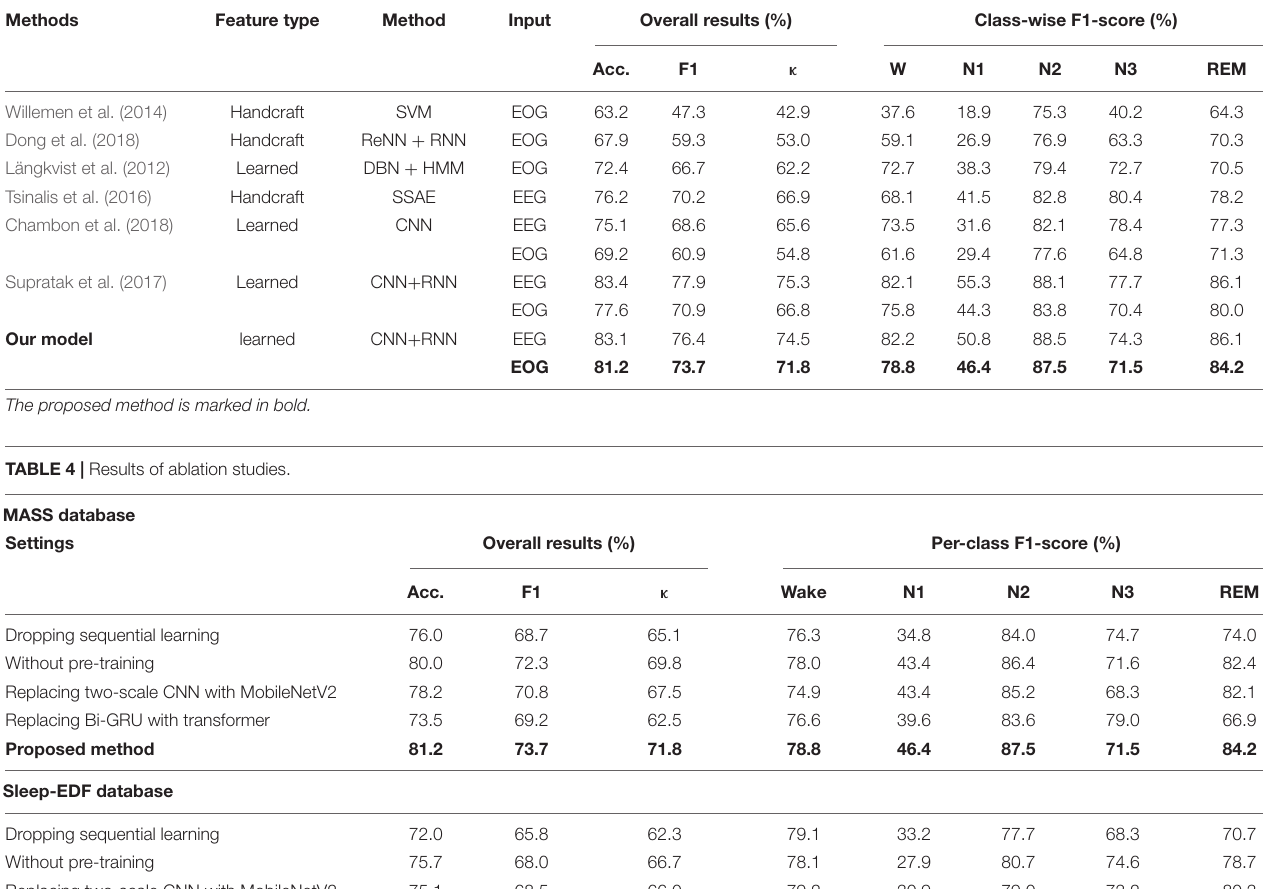
TABLE 3 | Results comparison of different methods using different features, classifiers, and signals. Methods